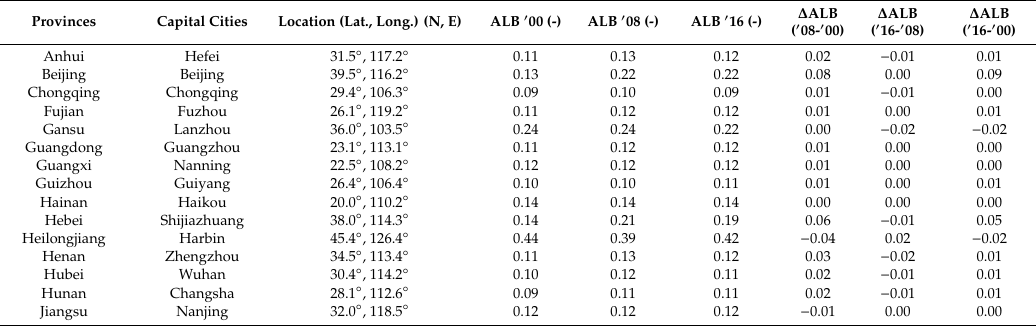
Table 1. Surface albedo of all provincial capitals and albedo variation from 2000 to 2016.